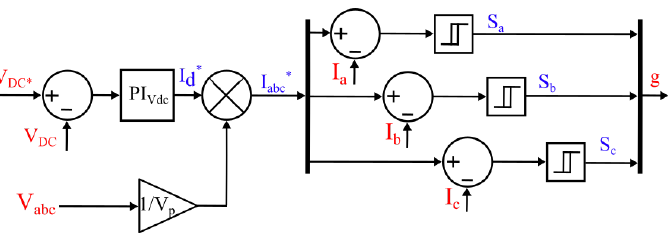
Figure 29. Hysteresis current control of AFE